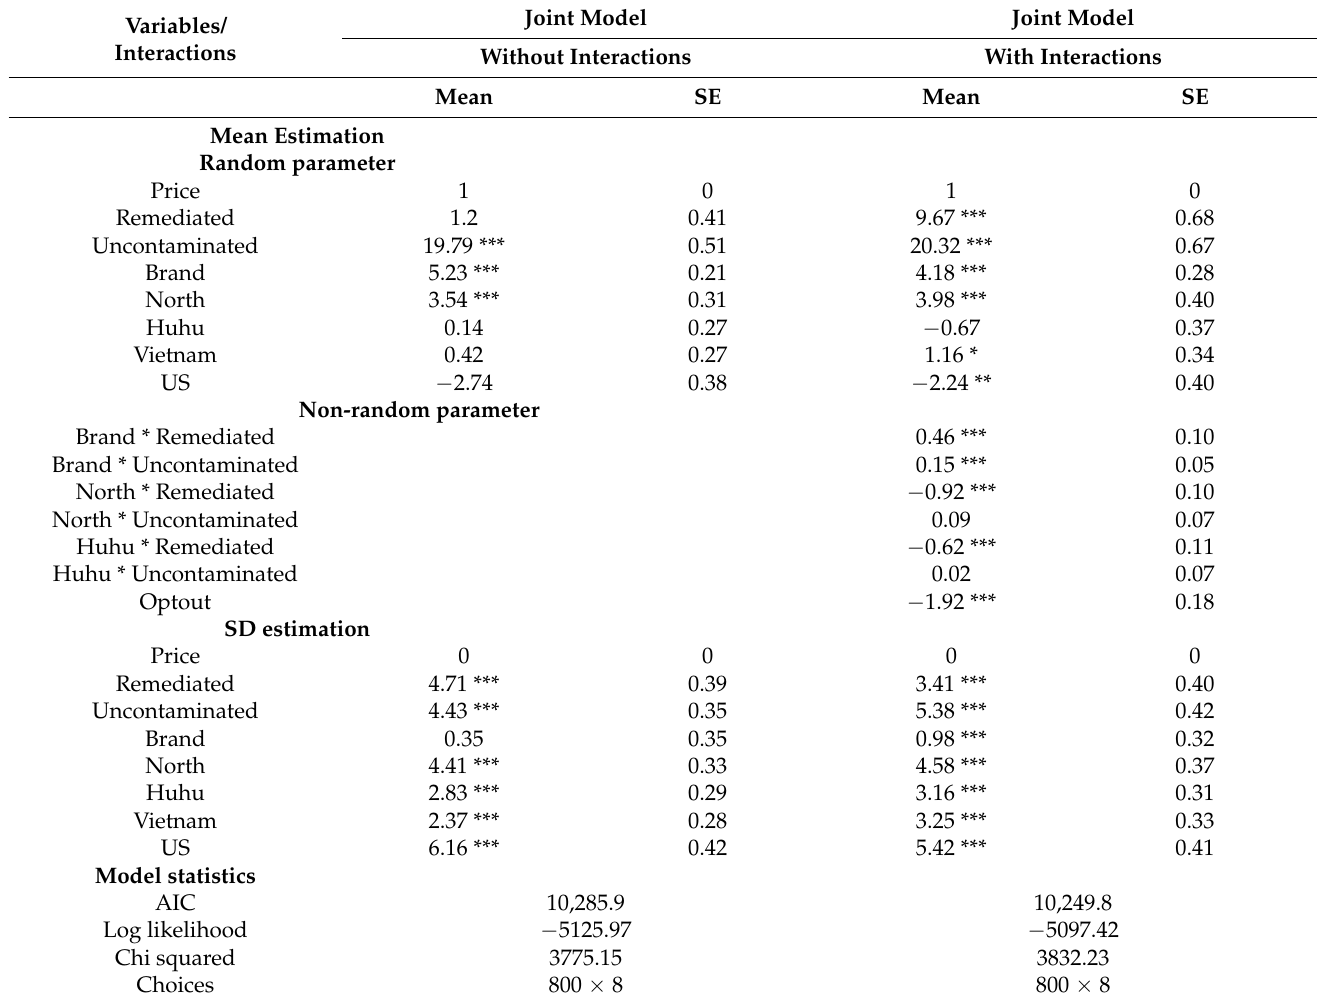
Table A1. RPL (WTP space) results of joint models with or without interaction